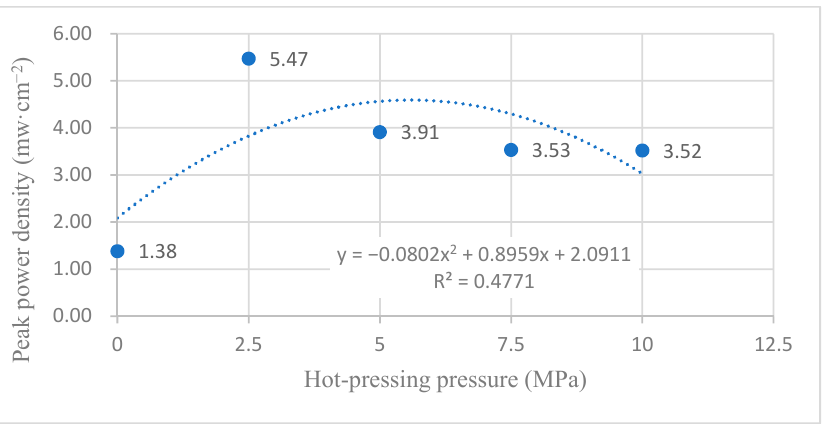
Figure 19. The fitting curve of the peak power density of MEA at different hot-pressing pressures under room temperature and air conditions.